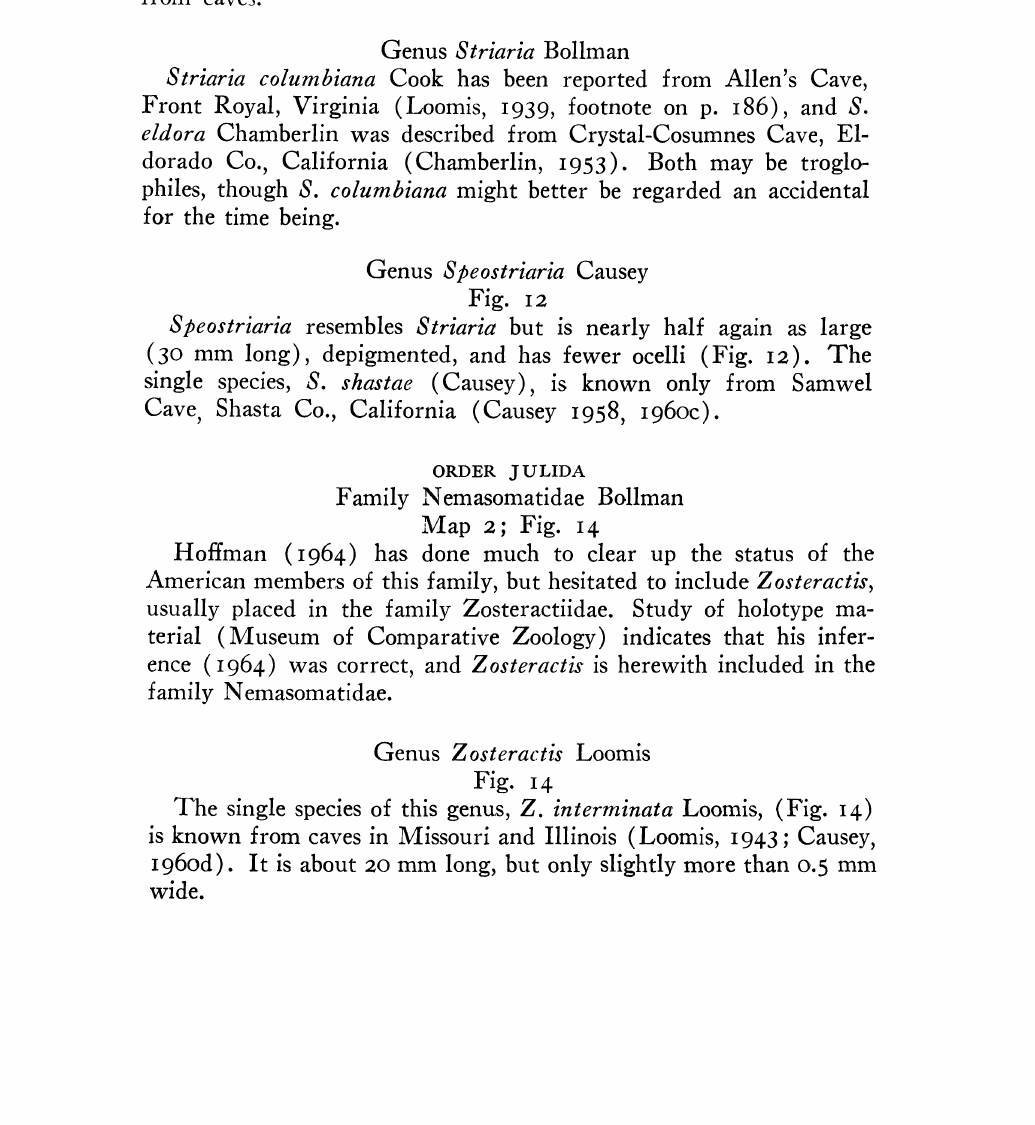
Fig. 12 Speostriaria resembles Striaria but is nearly half again as large